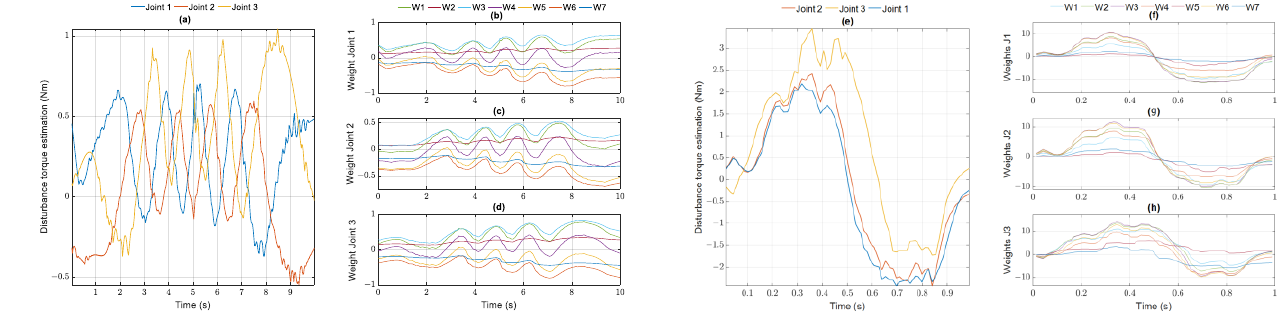
23 of 27 Figure 15. Control signals generated by the controllers in the helix and parabolic of case 1: ( a ) joint 1; ( b ) joint 2; ( c ) joint 3 in the helix trajectory; ( d ) joint 1; ( e ) joint 2; ( f ) joint 3 in the parabolic trajec- tory. Although the controller-based dynamic model can provide performance improve- ment in tracking control, PDFF improves the least values because of the lack of convergent functions in contrast to the robust PDSM or PDFS. The adaptive unknown torque approx- imation in the proposed approach reduces the effects of the disturbance, resulting in better